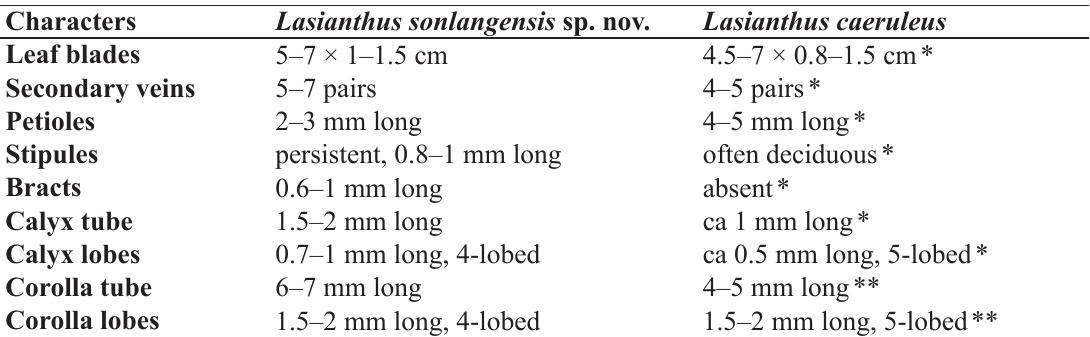
Table 2. Comparison of Lasianthus sonlangensis V.S.Dang, Vuong & Quan sp. nov. and L. caeruleus Pitard. * = from Pitard 1924; ** = from Dang 411 ,